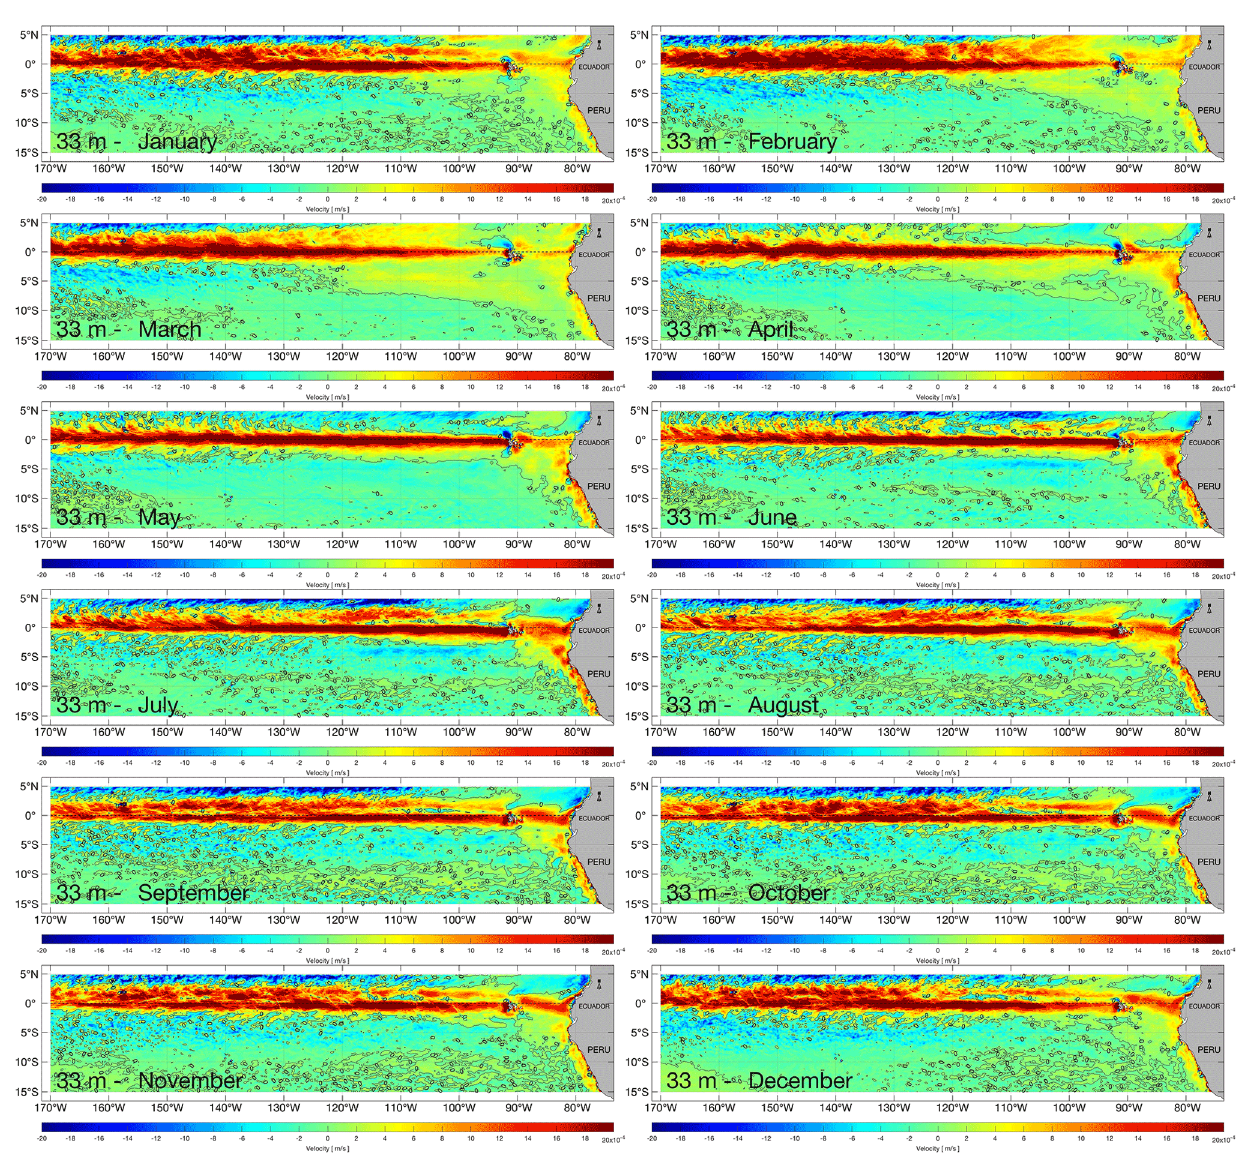
Figure 3. Monthly climatology (averaged over 1988–2007) of vertical velocity at a depth of 33m in the eastern Pacific from the NEMO- ORCA12